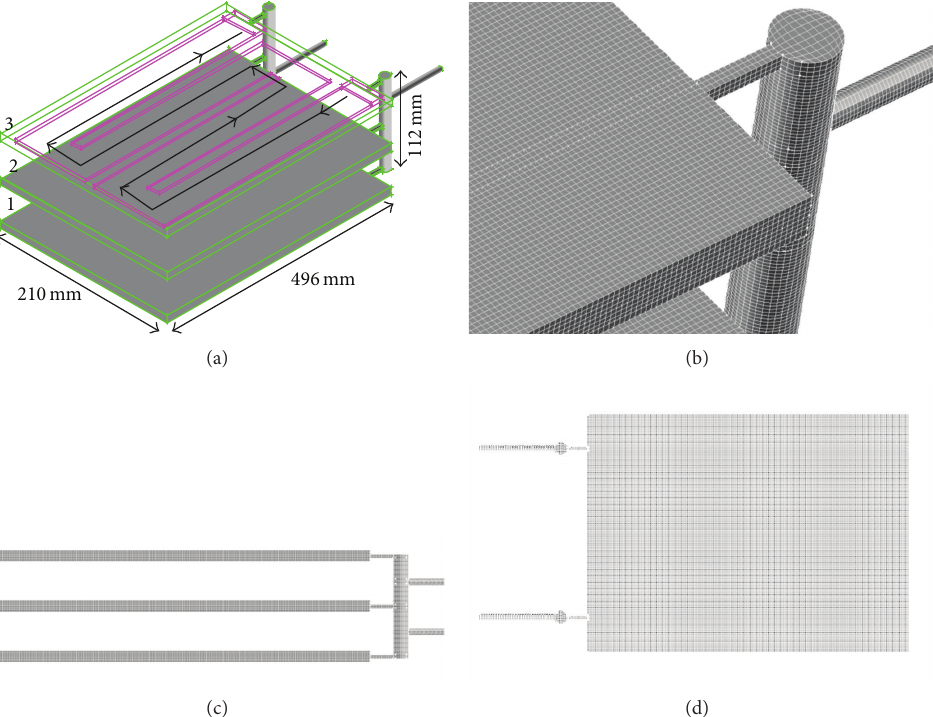
Figure 3: Three-dimensional graphics of shelves and shelf flow channel: (a) overall dimensions of shelves and flow channel structure; (b) local grid structure distribution; (c) side view of overall grid structure distribution; (d) top view of overall grid structure